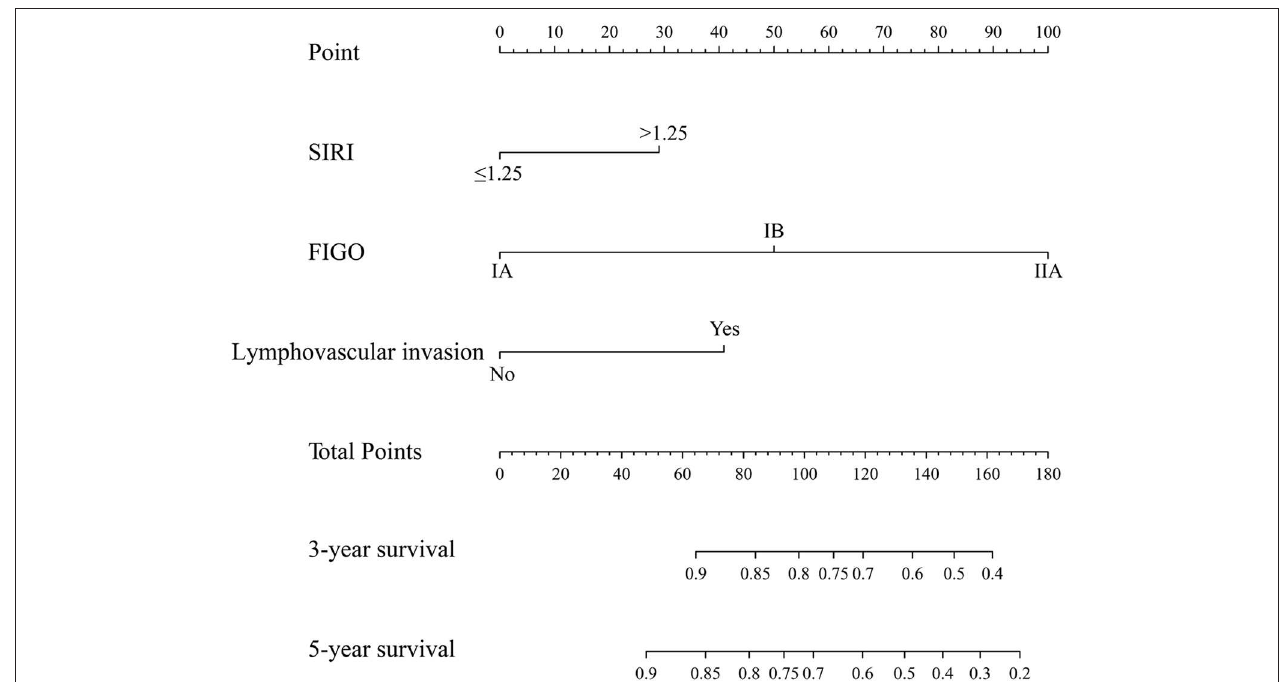
FIGURE 3 | The nomogram integrating SIRI, lymphovascular invasion and FIGO in operable cervical cancer.